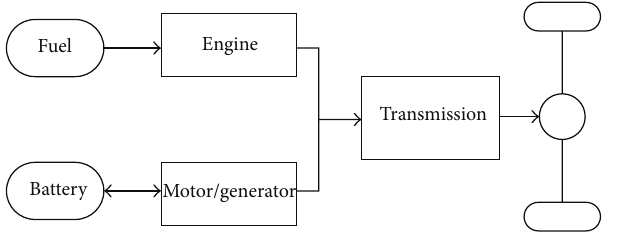
Figure 1: Parallel HEV configuration.